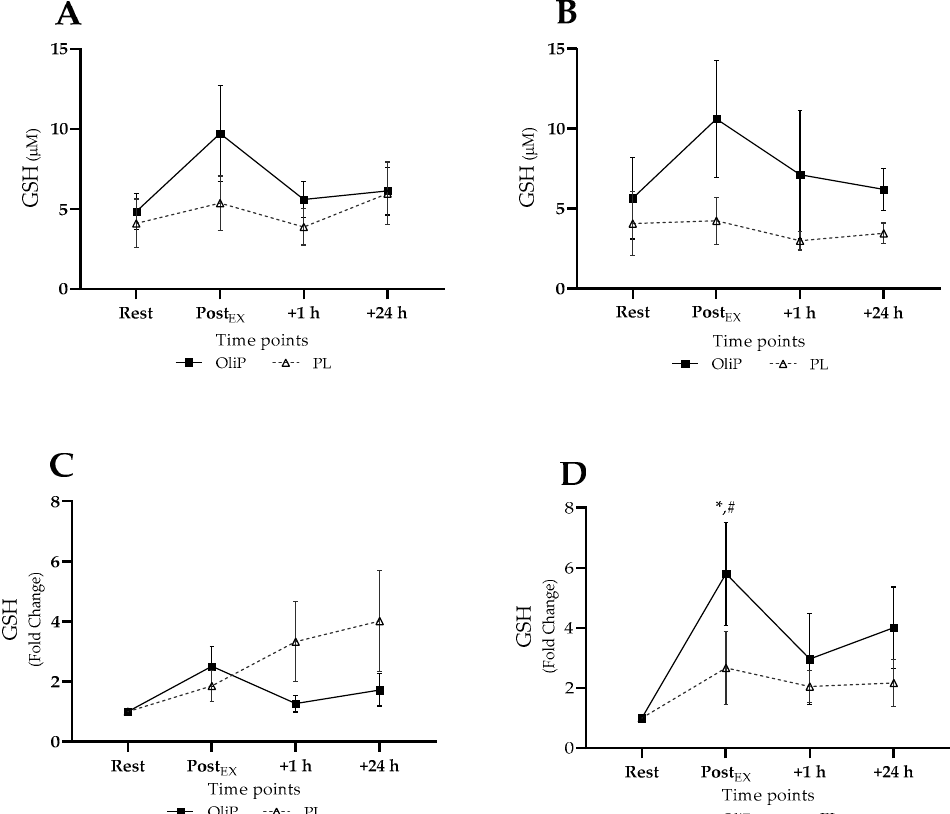
Figure 5. Plasma reduced glutathione (GSH) responses expressed in mean absolute ( µ M) and fold change terms in participants that were supplemented with OliPhenolia ® (OliP) for 16 consecutive days or with a matched placebo (PL). ( A , C ) Pre-intervention, before supplementation; ( B , D ) Post 16-day supplement intervention. * denotes significant difference compared to rest within trial ( p = 0.05). # difference between trials at comparative timepoint for OliP only ( p = 0.009).